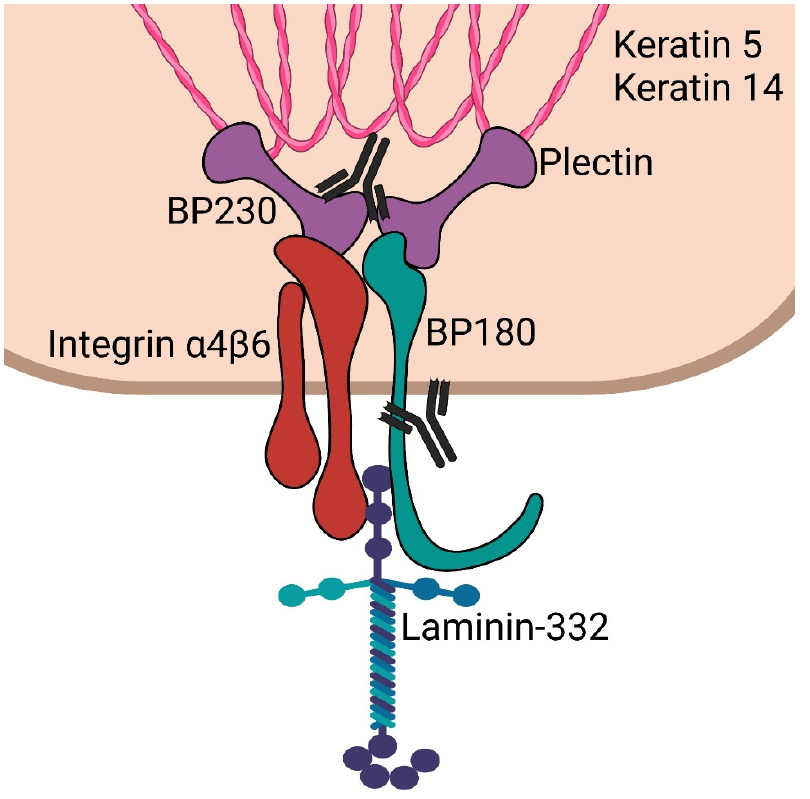
Figure 1. Schematic of epidermal hemidesmosome. BP230 and plectin bind to keratin intermediate filaments. These subsequently complex with integrin α 4 β 6 and BP180 (collagen 17). These then interact with laminin-332 in the lamina lucida. Antibodies are shown targeting the C-terminus of BP230 and the NC16a domain of BP180, which are most often targeted in bullous pemphigoid.